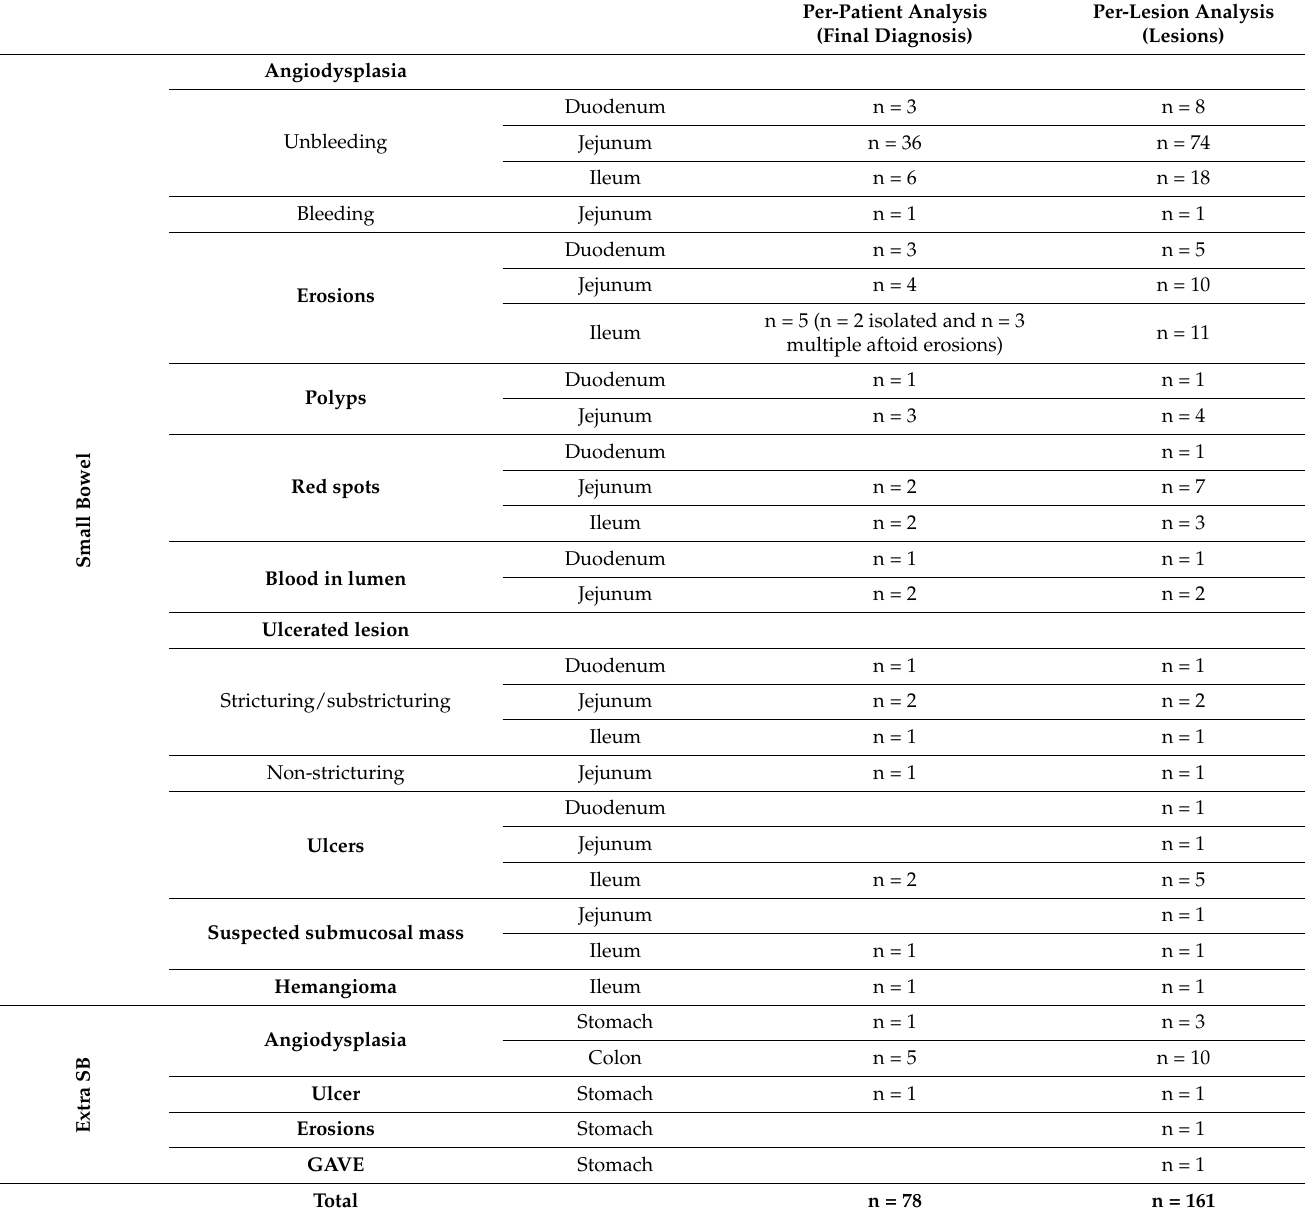
Table 3. Capsule endoscopy